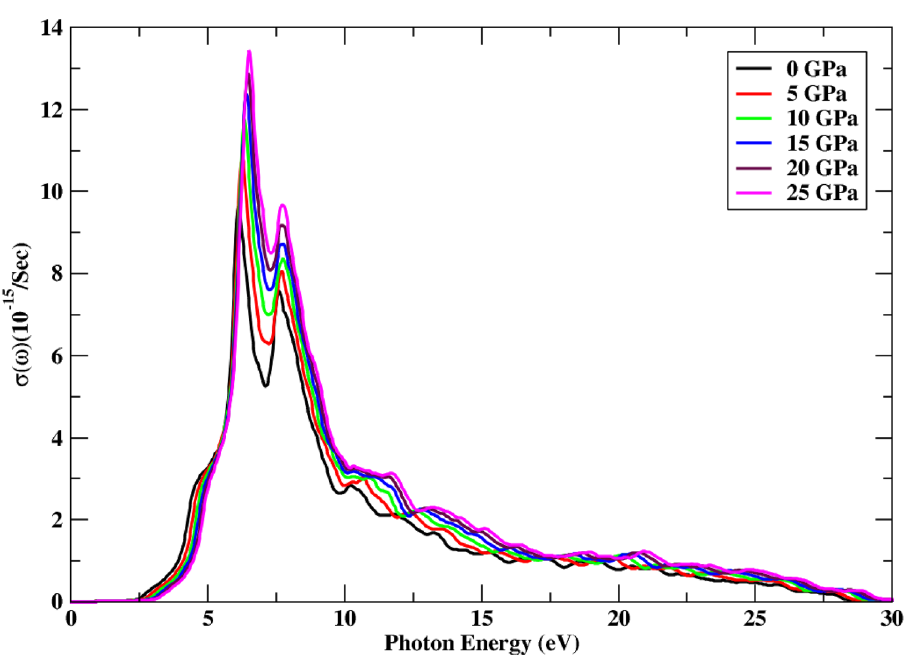
Figure 7. Change in optical conductance under the effect of